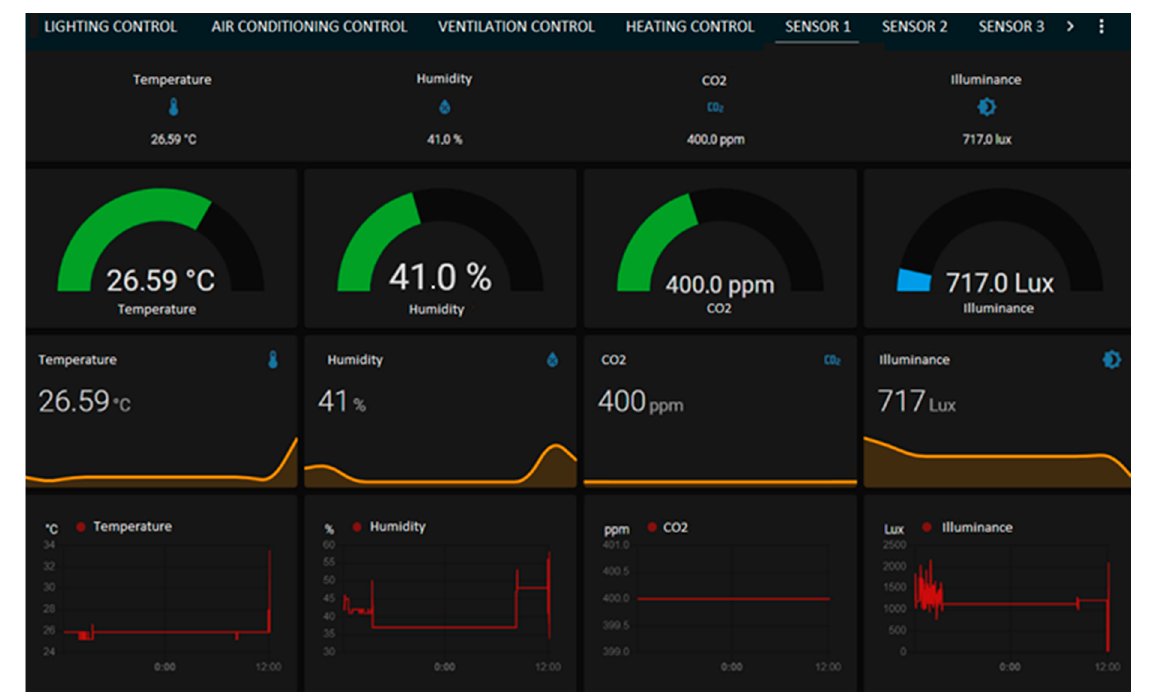
Figure 13. Environmental sensor observation panel designed by CBRTI Sp. z o.o. Research and Development Center.